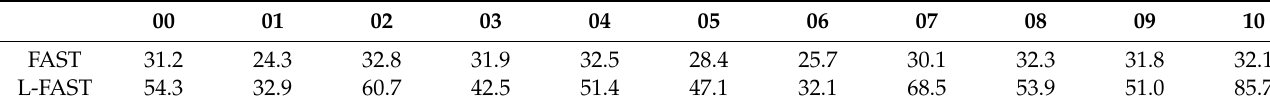
Table 5. The running time of each frame for sequences from 00 to 10 (unit: ms).